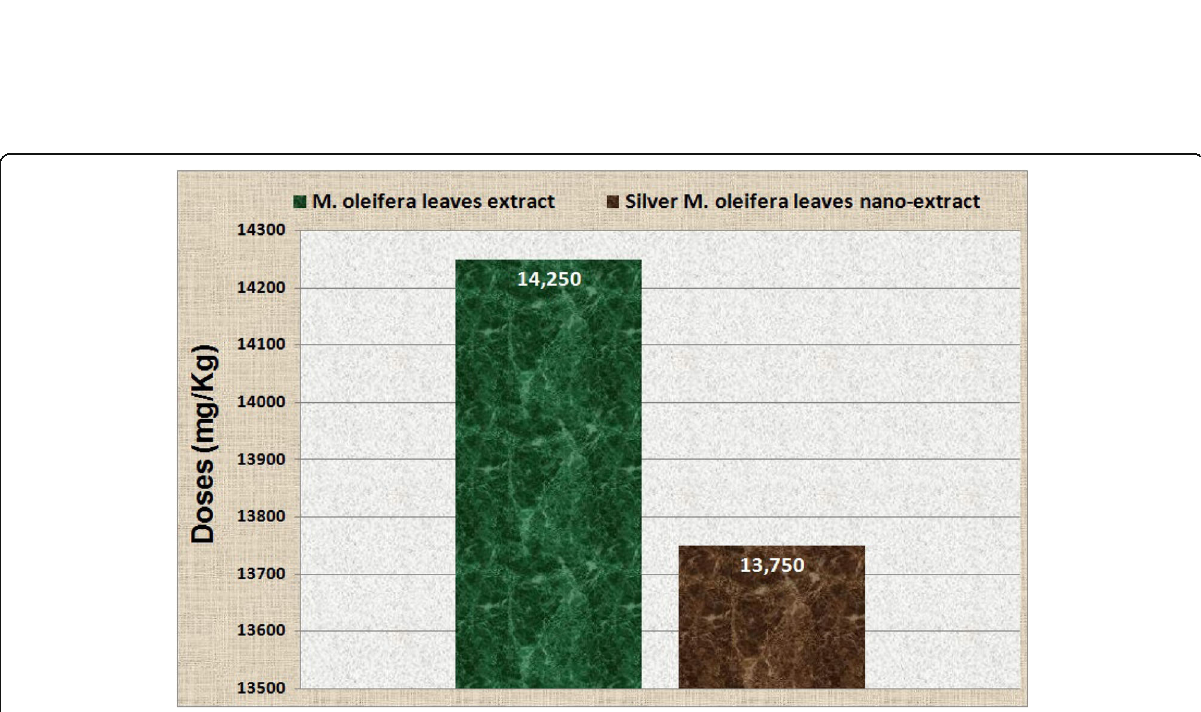
Fig. 4 The median lethal doses (LD 50 ) of the M. oleifera leaves extract and silver M. oleifera leaves nano-extract